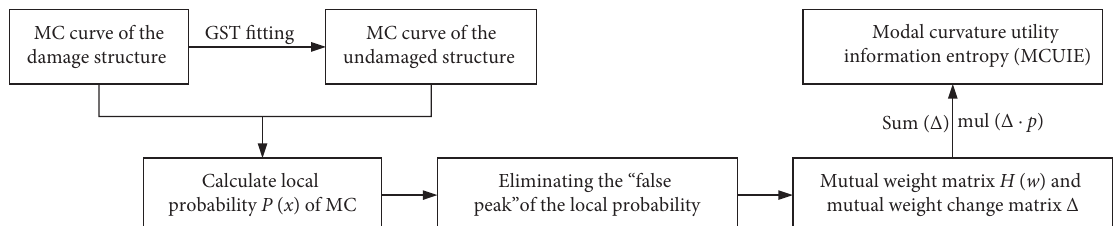
Figure 8: Calculation process of MCUIE index.